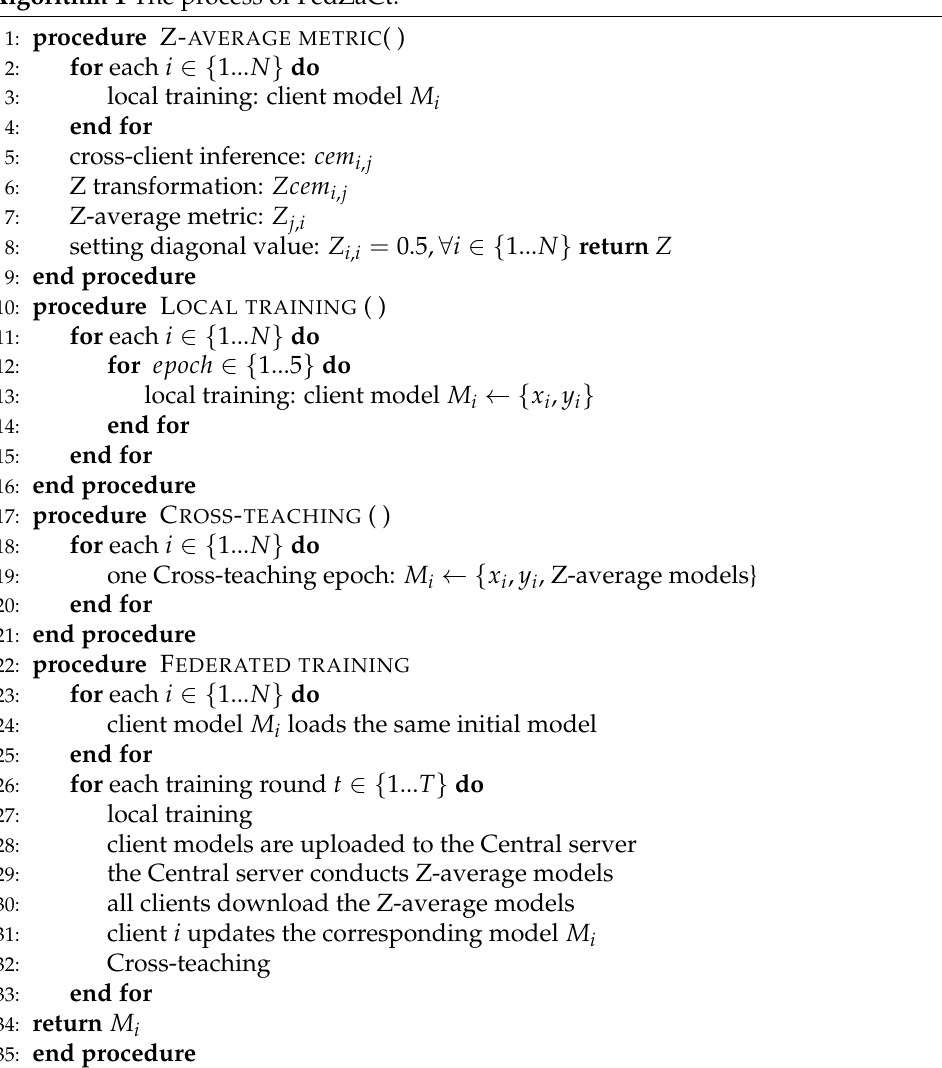
Algorithm 1 The process of